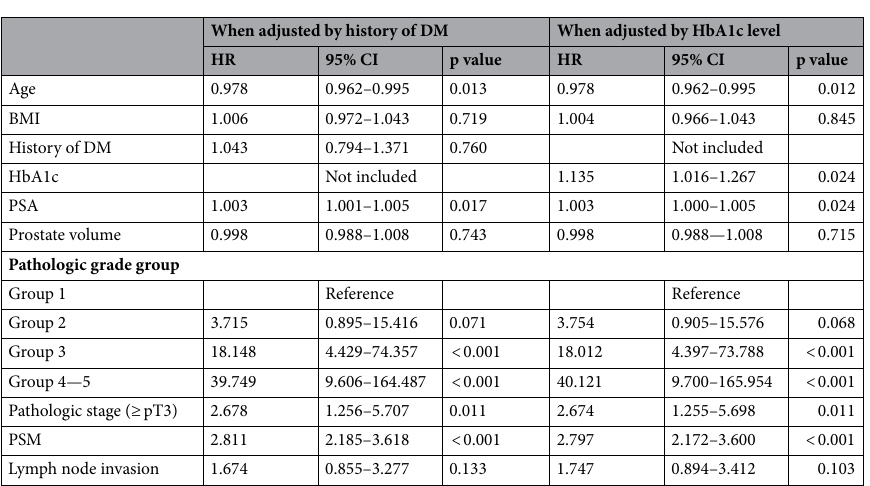
Table 3. Multivariate analyses using Cox proportional hazard model on biochemical recurrence. BMI Body mass index, DM diabetes mellitus, HbA1c hemoglobin A1c, PSA prostate specific antigen, PSM positive surgical